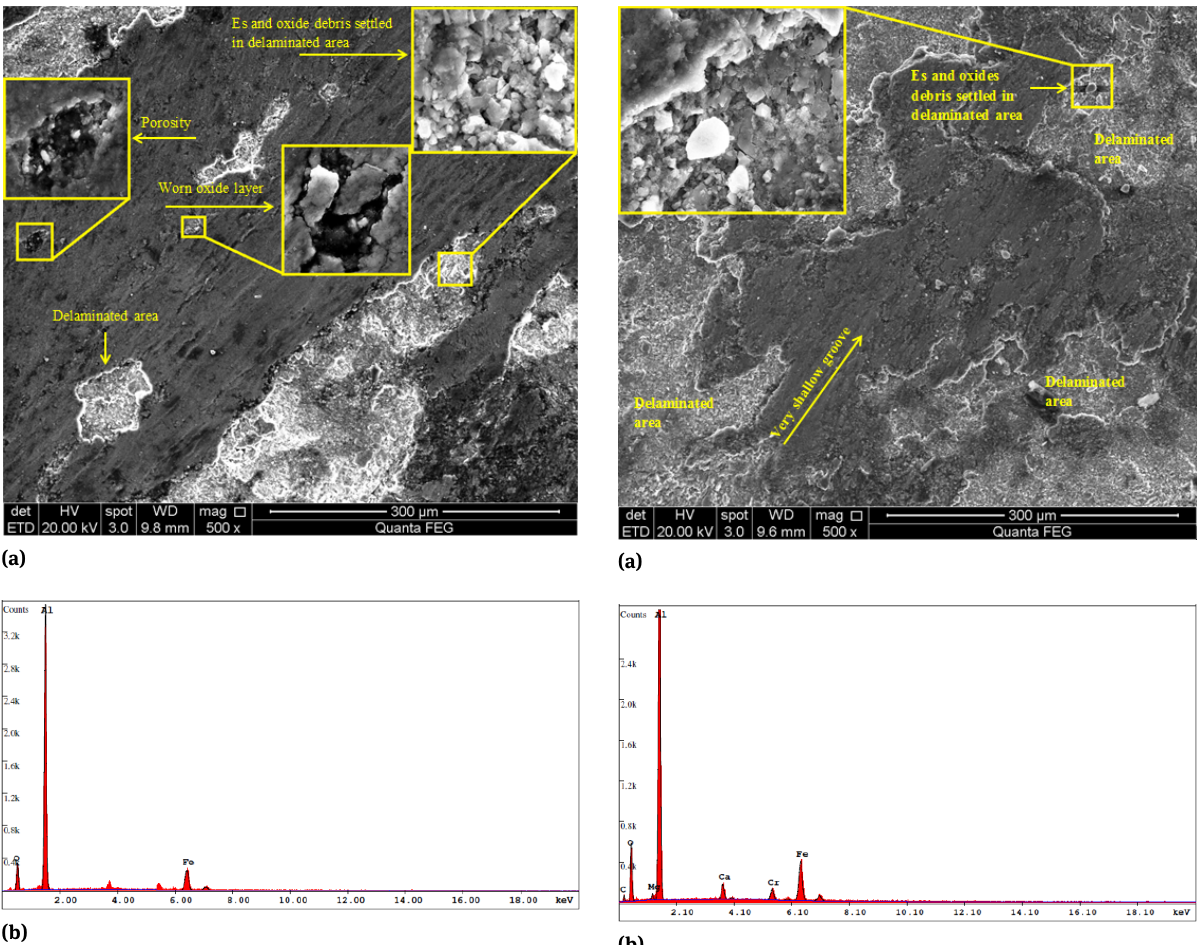
Figure 12: (a) SEM micrograph of worn out surfaces of Al-1.5Mg- 1.5Sn-3Es composite showing smooth hard oxide layer and delam- inated area, (b) EDX of marked worn oxide layer of Al-1.5Mg-1.5Sn- 3Es presented in (a).